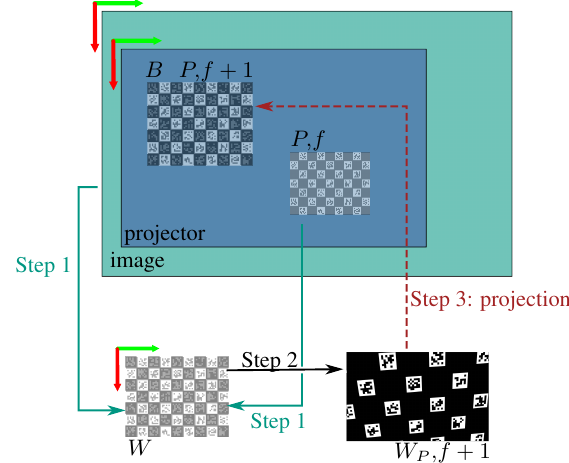
Figure 3. Use of a homography to warp the projected pattern. After applying the transformation, the projected pattern comple- ments the printed